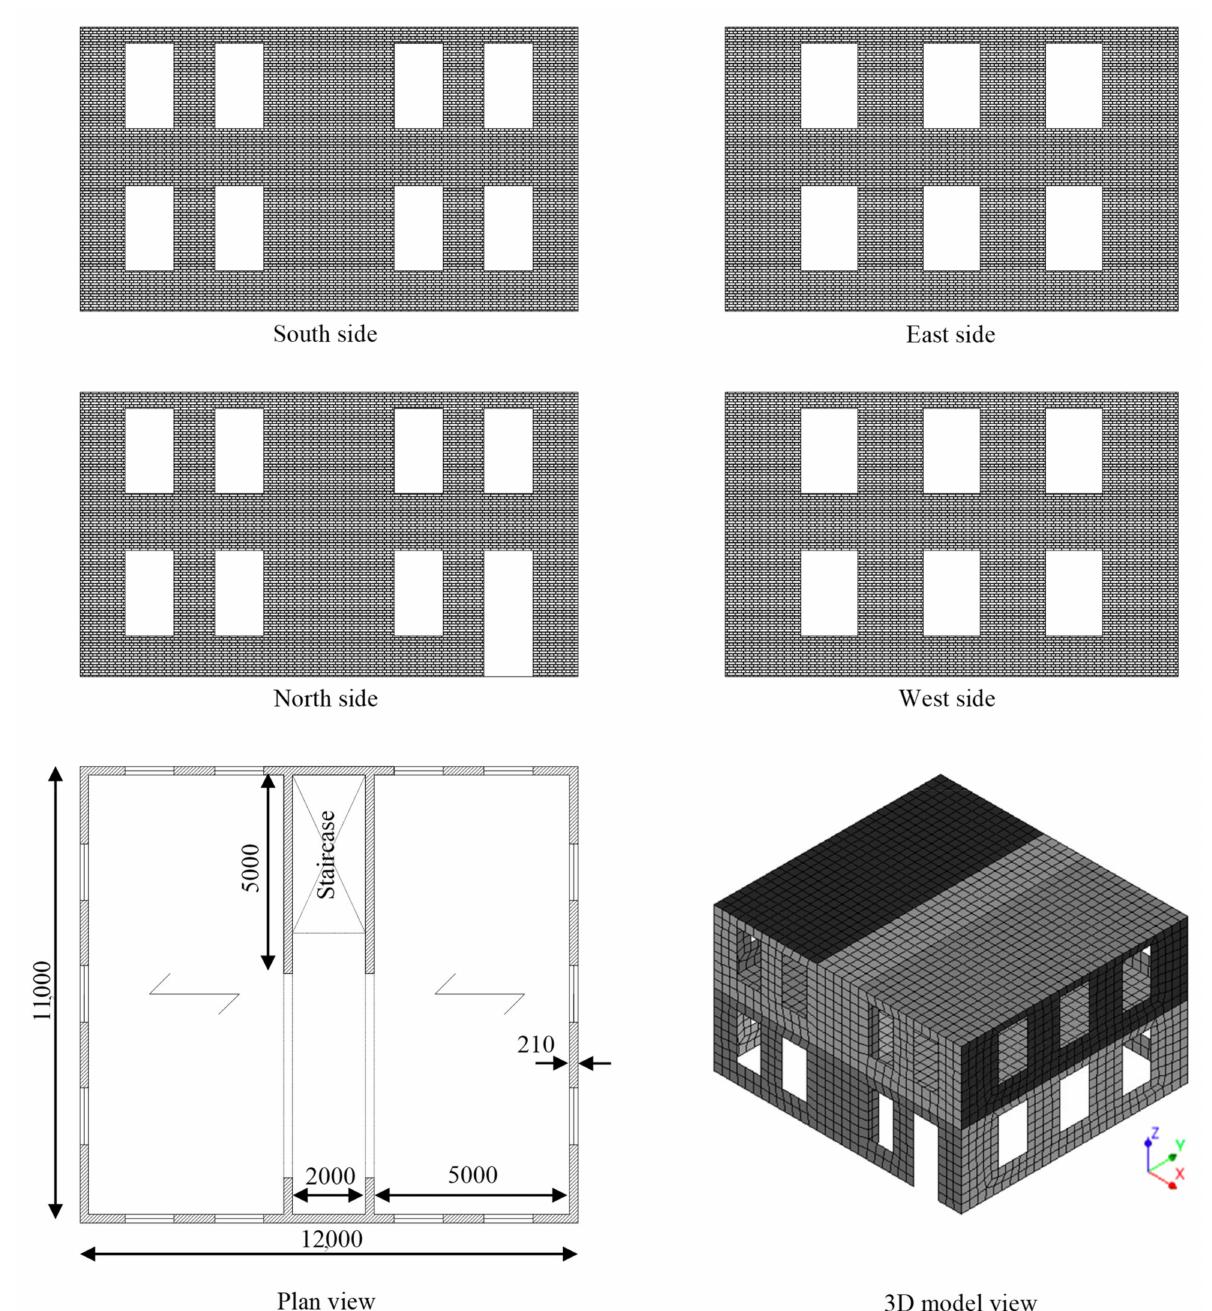
Figure 7. Main properties and geometry of the second case–study building B2 (dimensions in mm). In the configurations featuring diaphragms retrofitted by casting a concrete slab on them, the floors were modeled with linear elastic isotropic shell elements, having the properties of structural reinforced concrete (Table 6). The thickness of the slab was once more 50 mm, and a continuous, hinged connection to the walls was assumed after